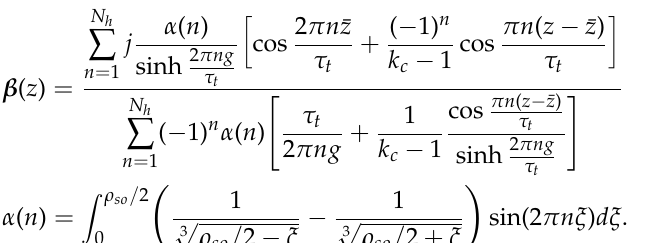
with z = x + jy being a generic complex point inside the air-gap domain. After choosing a horizontal line at y = y e , (7) was multiplied by the no load slottess flux density vector (retrieved along the same line) obtaining the slotted flux density no-load vector, which has been proven to work well [14].